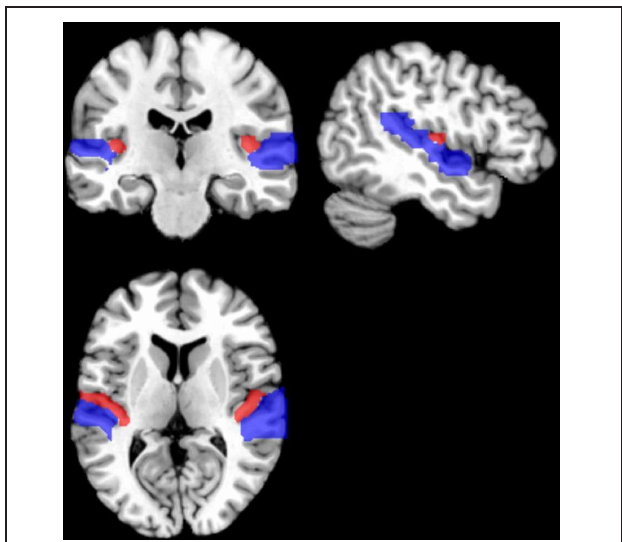
FIGURE 1 | Schematic illustration of the primary auditory cortex (PAC) on a brain template. The PAC occupies most of the Heschl’s gyrus (red), which extends mediolaterally within the Sylvian fissure. PAC is surrounded by auditory association areas on the superior temporal gyrus